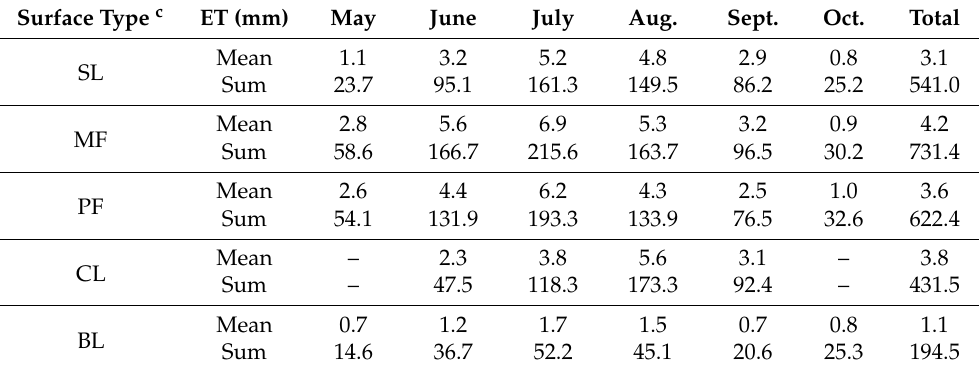
Table 5. Monthly variation in evapotranspiration (ET) over five surface types in the Ejina Oasis during the growing season in